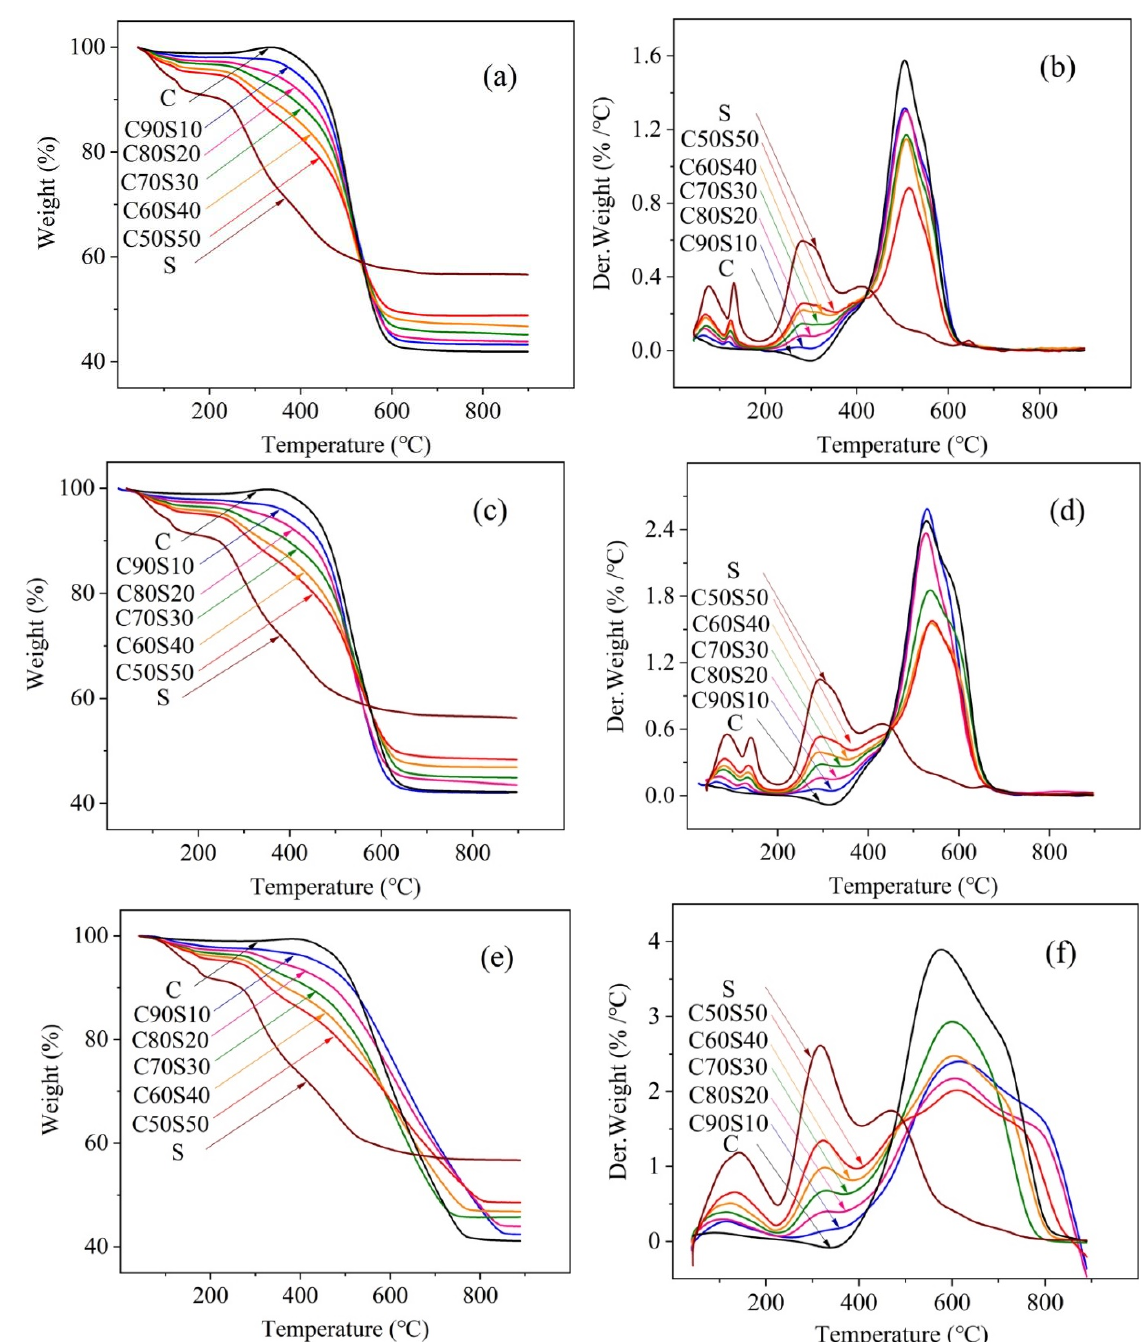
Figure 1. The TG and DTG curves of coal, municipal sludge and blends thereof at heating rates of 10 ( a , b ), 20 ( c , d ) and 60 ( e , f ) °C/min.